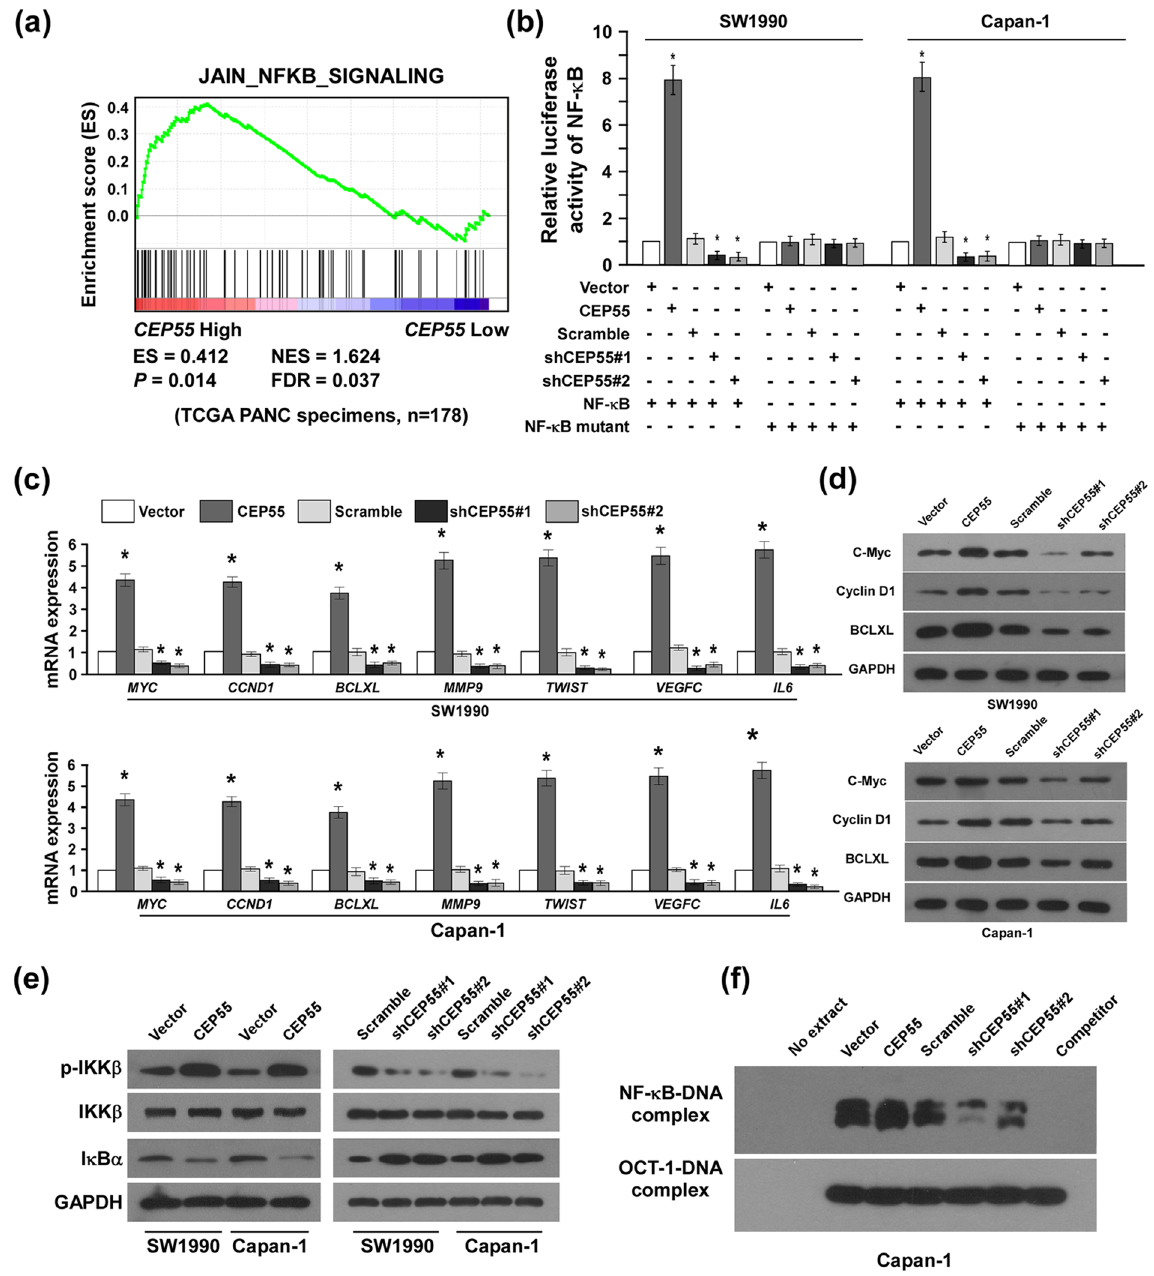
Figure 5. CEP55 activated NF- κ B signalling. ( a ) Gene set enrichment analysis (GSEA) plot indicating a significant correlation between the CEP55 gene expression level and nuclear factor kappaB (NF- κ B)-activated gene signatures (JAIN_NF- κ B_SIGNALING). ( b ) Luciferase-reported NF- κ B activity in SW1990 and Capan-1 cells transduced with CEP55 or shCEP55. ( c ) Changes in mRNA expression of NF- κ B downstream targets ( MYC , CCND1 , BCLXL , MMP9 , TWIST , VEGFC and IL6 ) in the indicated cells assessed by real-time PCR. ( d ) Changes in protein expression of NF- κ B downstream targets (C-Myc, Cyclin D1 and BCLXL) in the indicated cells assessed by western blot. ( e ) Western blotting analysis of p-IKK β , IKK β , and I κ B α expression in SW1990 and Capan-1 cells transduced with CEP55 or shCEP55. ( f ) The endogenous NF- κ B activity in the indicated cells detected by an electrophoretic mobility shift assay (EMSA). The Oct-1-DNA complex served as a